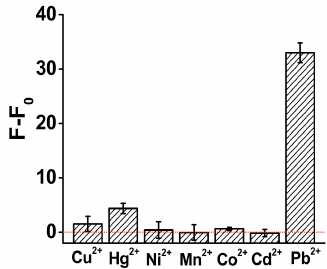
Figure 6. Investigation results of the specificity of the Pb 2+ sensor. The concentration of all the metal ion solutions was 100 nM. All the analysis experiments were performed under the same condition.